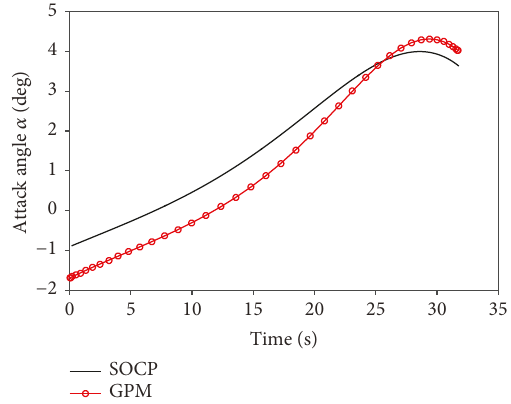
Figure 5: The penetrator ’ s attack angle pro fi les, using the two methods.